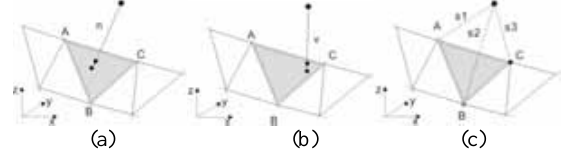
Figure 1. Conjugate points definitions for surface matching with TIN structure: (a) LND rule, (b) LZD rule, (c) ICP